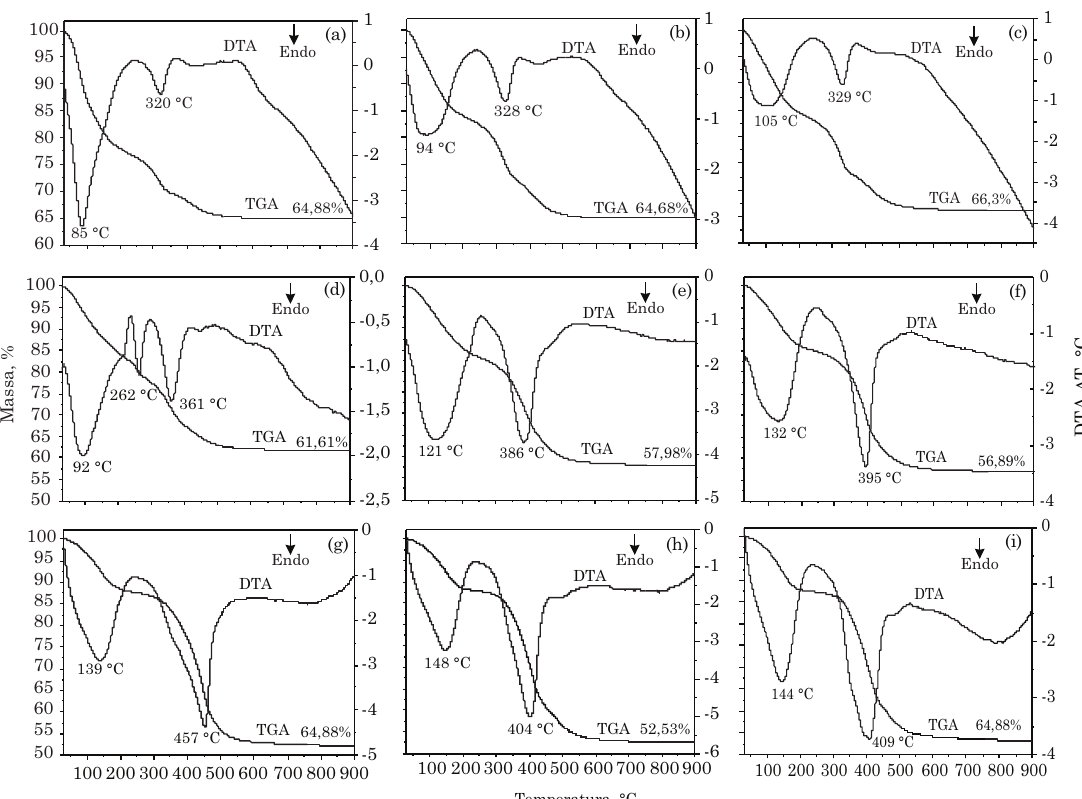
Figura 3. Medidas de análise térmica (TGA e DTA) para os compostos: HDL-Mg 3 Fe 1 - pH 9,5 (a); HDL-Mg 4 Fe 1 - pH 9,5 (b); HDL-Mg 5 Fe 1 - pH 9,5 (c); HDL-Mg 2 Al 0,5 Fe 0,5 - pH 8 (d); HDL-Mg 2 Al 0,5 Fe 0,5 - pH 9 (e); HDL- Mg 2 Al 0,5 Fe 0,5 - pH 10 (f); HDL-Mg 3 Al 1 - pH 10 (g); HDL-Mg 4 Al 1 - pH 10 (h); e HDL-Mg 5 Al 1 - pH 10